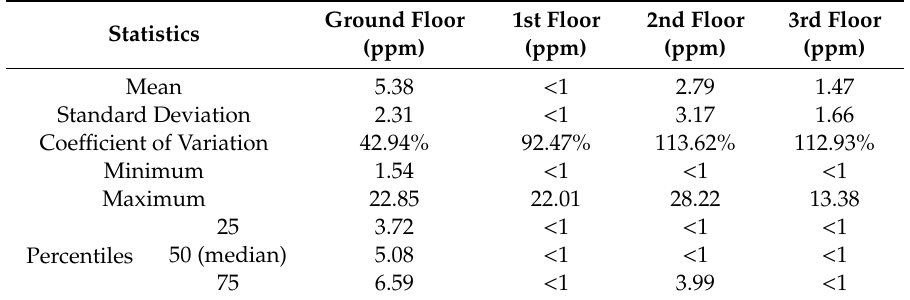
Table 5. Descriptive statistics for TVOC in each floor, for all experimental periods (April 2018–March